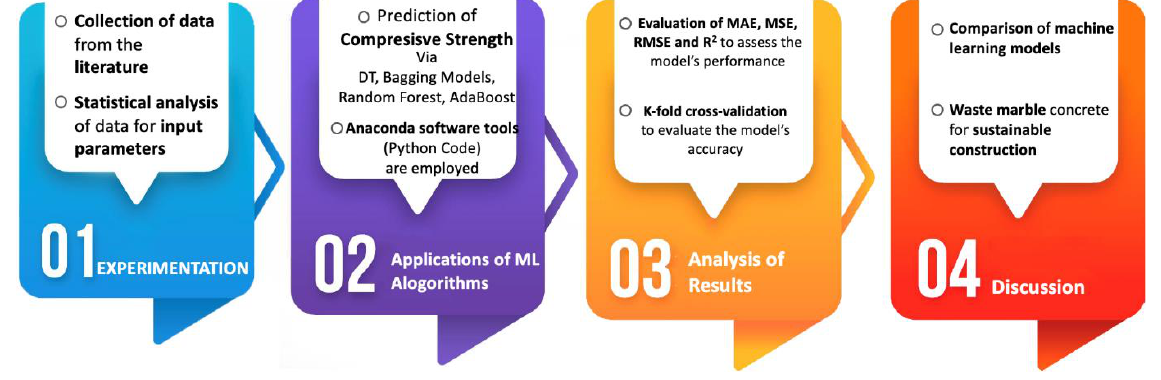
Figure 8. Research Figure 8. Research methodology.